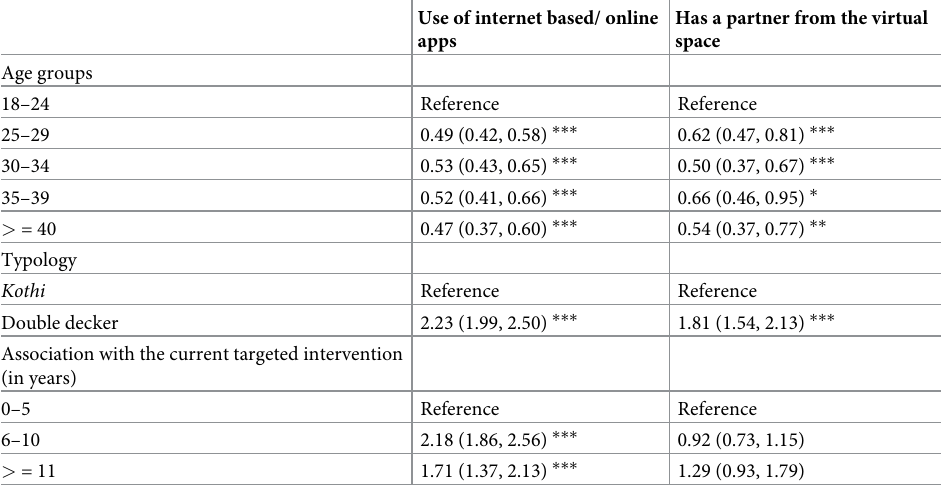
Table 4. Logistic regression models for “use of online/mobile apps” and “having a partner from the virtual space” among 8582 men have sex with men, Mumbai,